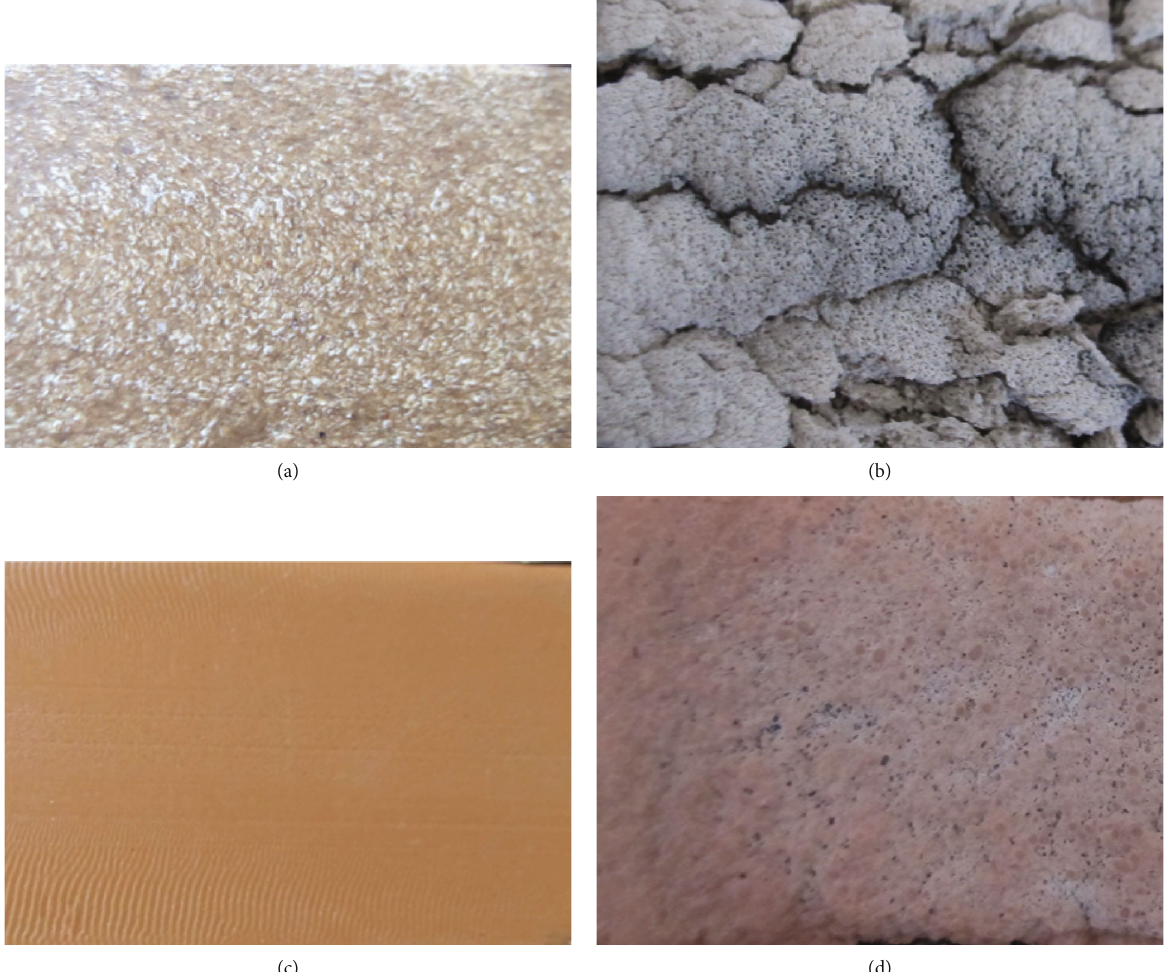
Figure 6: Photographs of the char residues on the samples subjected to the cone calorimetry: (a) core, (b) 20 wt% talc- fi lled shell layer, (c) core, and (d) core-shell structured composites with a HDPE